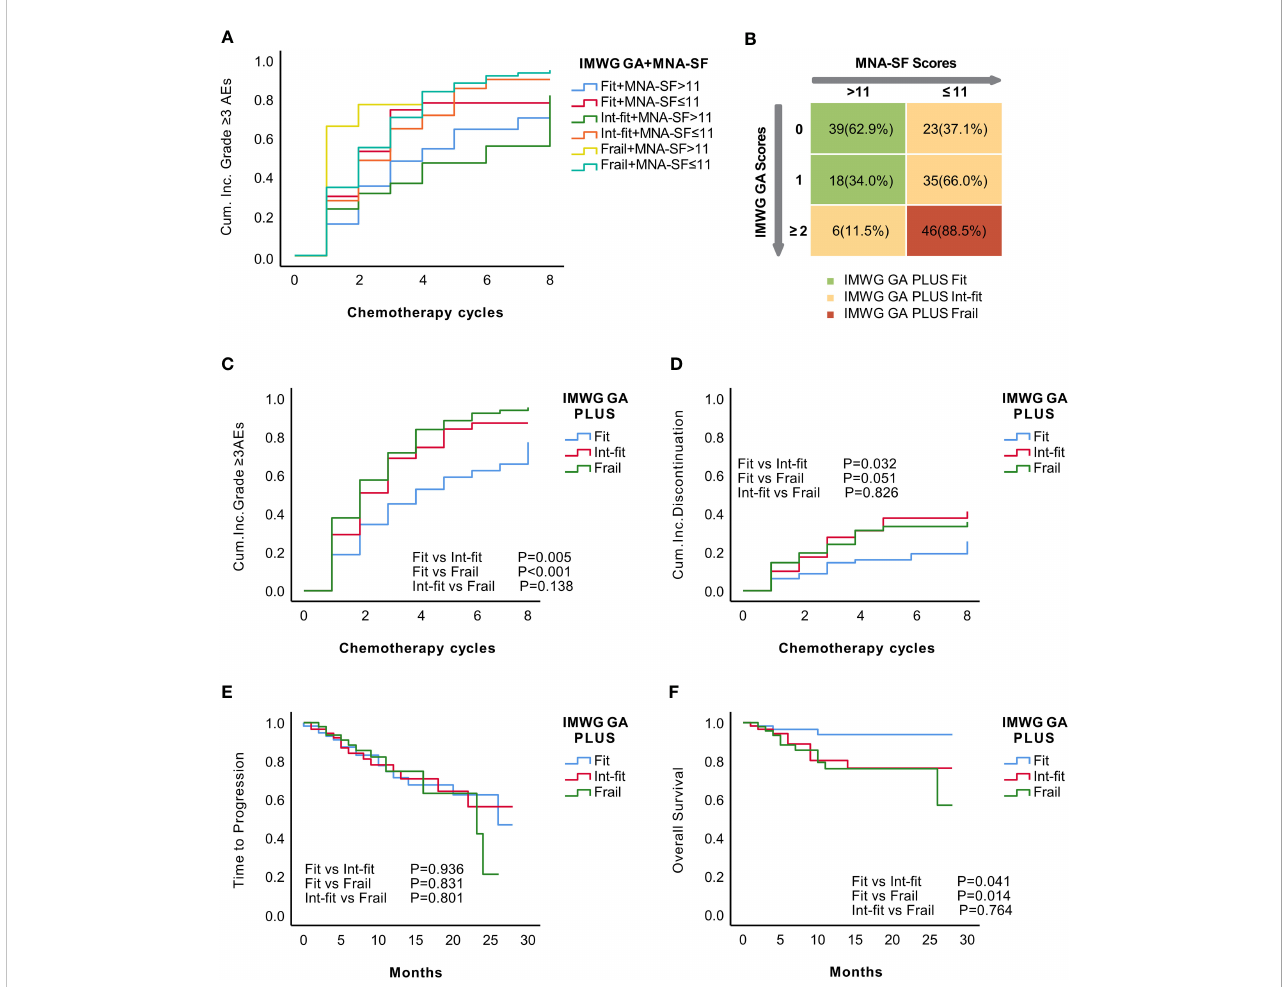
FIGURE 3 Establishment of the IMWG GA PLUS frailty score as the combination of the IMWG GA score and the MNA-SF score of the CGA. KM analysis for the occurrence of grade ≥ 3 AEs in recategorized subgroups according to the combination of the IMWG GA and MNA-SF (A) . Distribution of MNA-SF score in the IMWG GA subgroups and the fi nal grouping using the IMWG GA PLUS frailty score (B) . The KM curve showed that IMWG GA PLUS signi fi cantly distinguished the risk of grade ≥ 3 AEs (C) and tended to distinguish the risk of treatment discontinuation (p=0.051) between patients in the fi t and frail subgroups (D) . There was no signi fi cant difference in TTP (E) . The KM curve for OS of IMWG GA PLUS seemed similar to that of the IMWG GA (F)